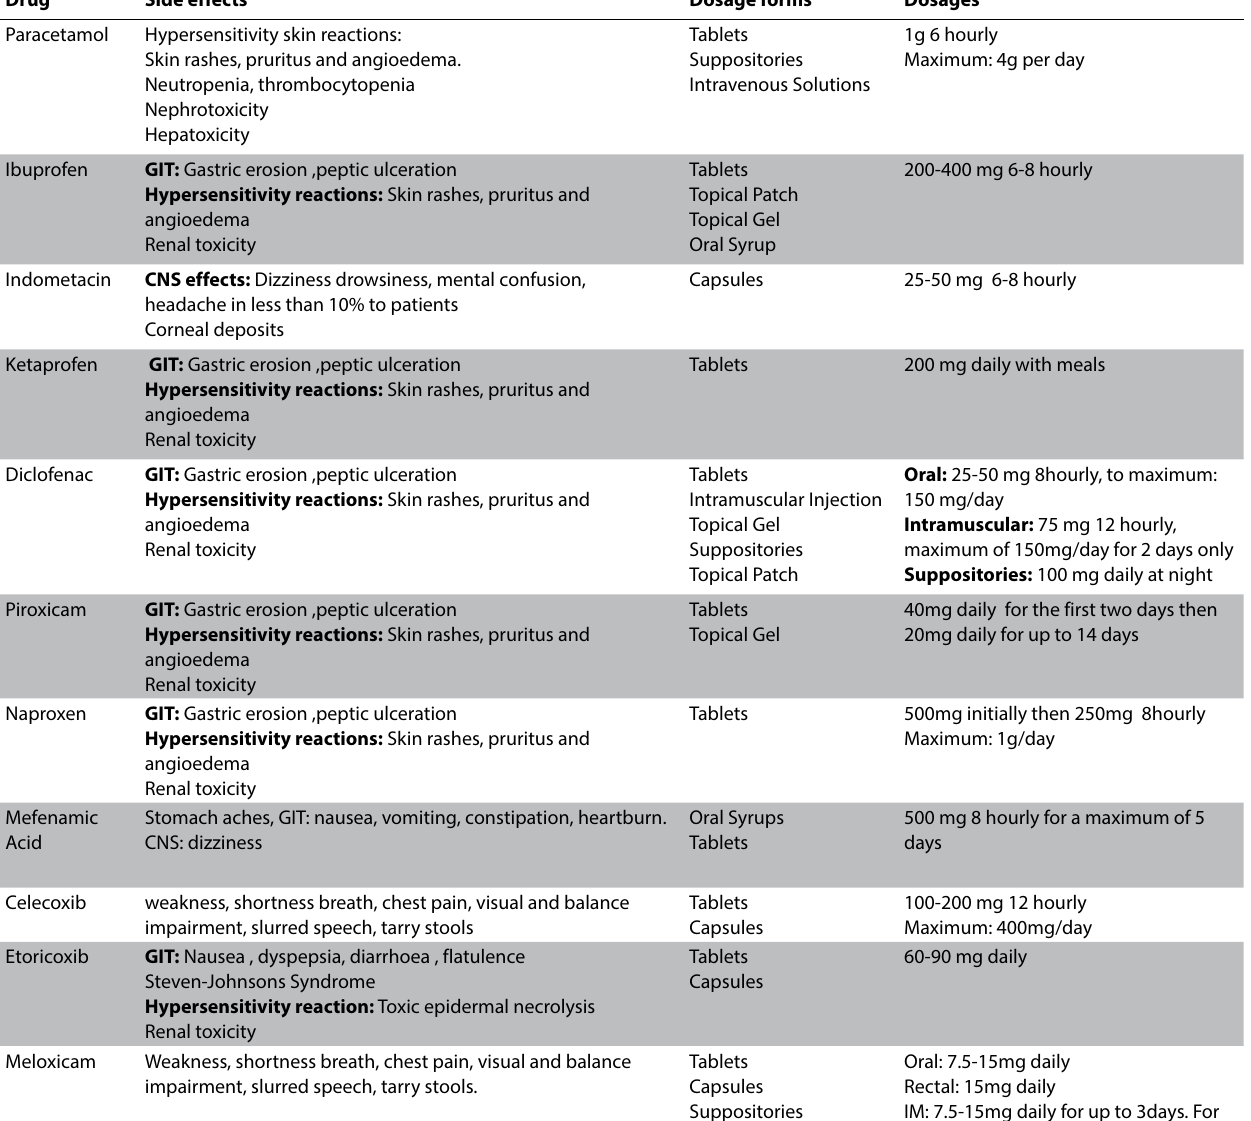
Table 6: Formulations, dosages and side-effects of various pain medications